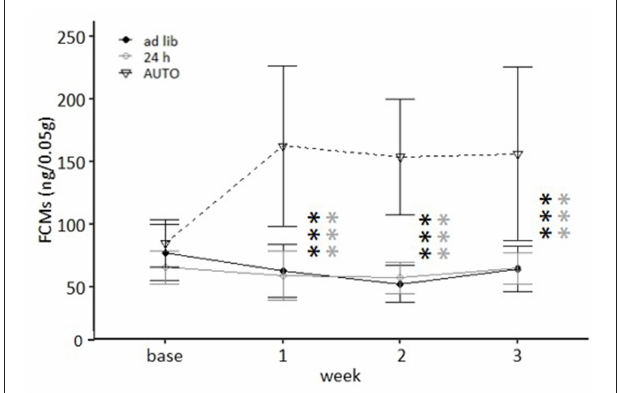
FIGURE 7 | Weight development under different feeding routines over a period of 9 weeks. Initial weight, Ad libitum feeding for all groups, before onset of feeding routines, Ad lib , Ad libitum group; 24h, 24h schedule group; AUTO, Automated feeding routine group. Data are presented as means ± SD. Statistics: repeated measures ANOVA, post hoc : Bonferroni-Holm corrected; sample size: n = 12 per group; * p < 0.05, ** p < 0.01, *** p < 0.001. Gray asterisks: comparison ad lib and 24 h, black asterisks: comparison ad lib and AUTO.